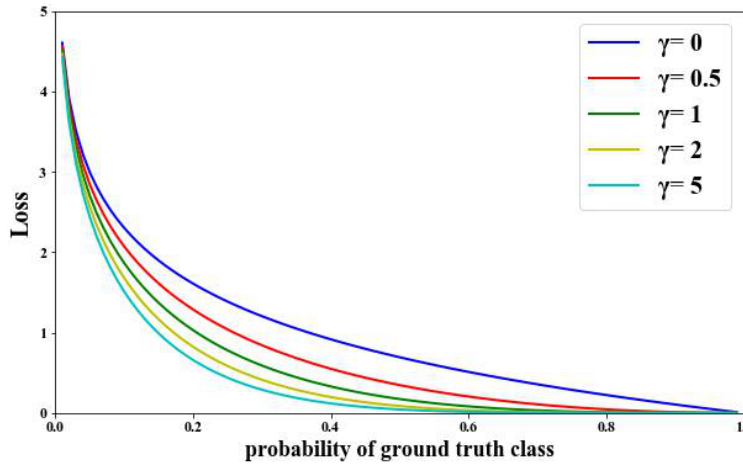
Figure 3. Focal Loss function diagram.